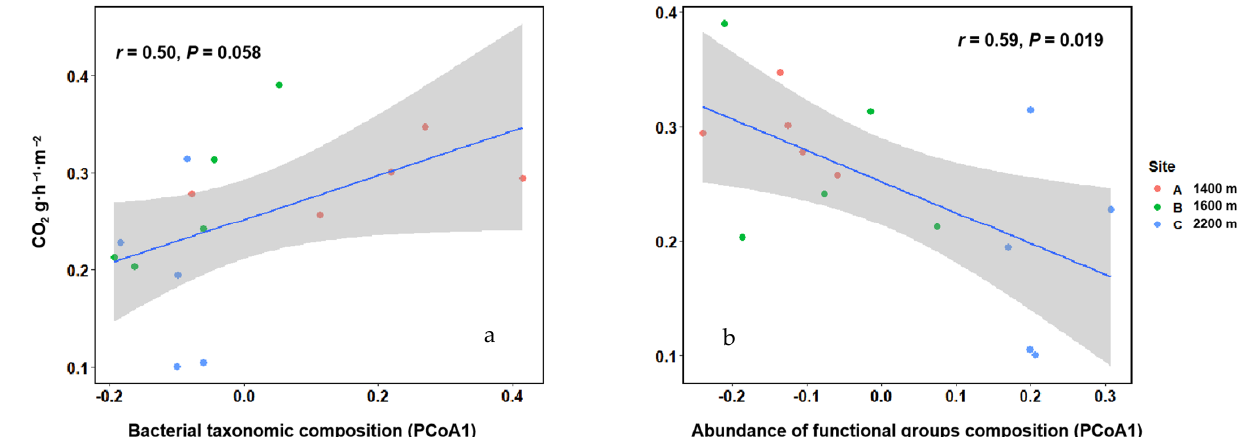
Figure 6. Correlations between CO 2 effluxes and the bacterial composition and abundances of mi ‐ crobial functional groups with the first axis of PCoA. ( a ) Correlations between soil CO 2 effluxes and bacterial taxonomic composition. ( b ) Correlations between soil CO 2 effluxes and abundances of mi ‐ crobial functional groups composition.